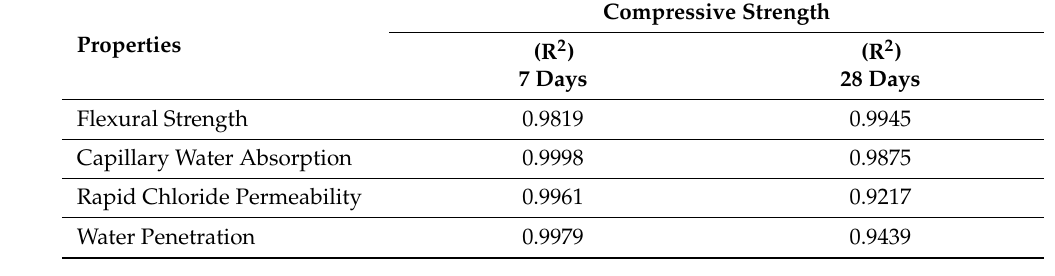
Figure 9. Correlation relations between mechanical and durability properties with compressive strength. Table 3. Correlation coefficients between mechanical and durability properties with compressive strength.